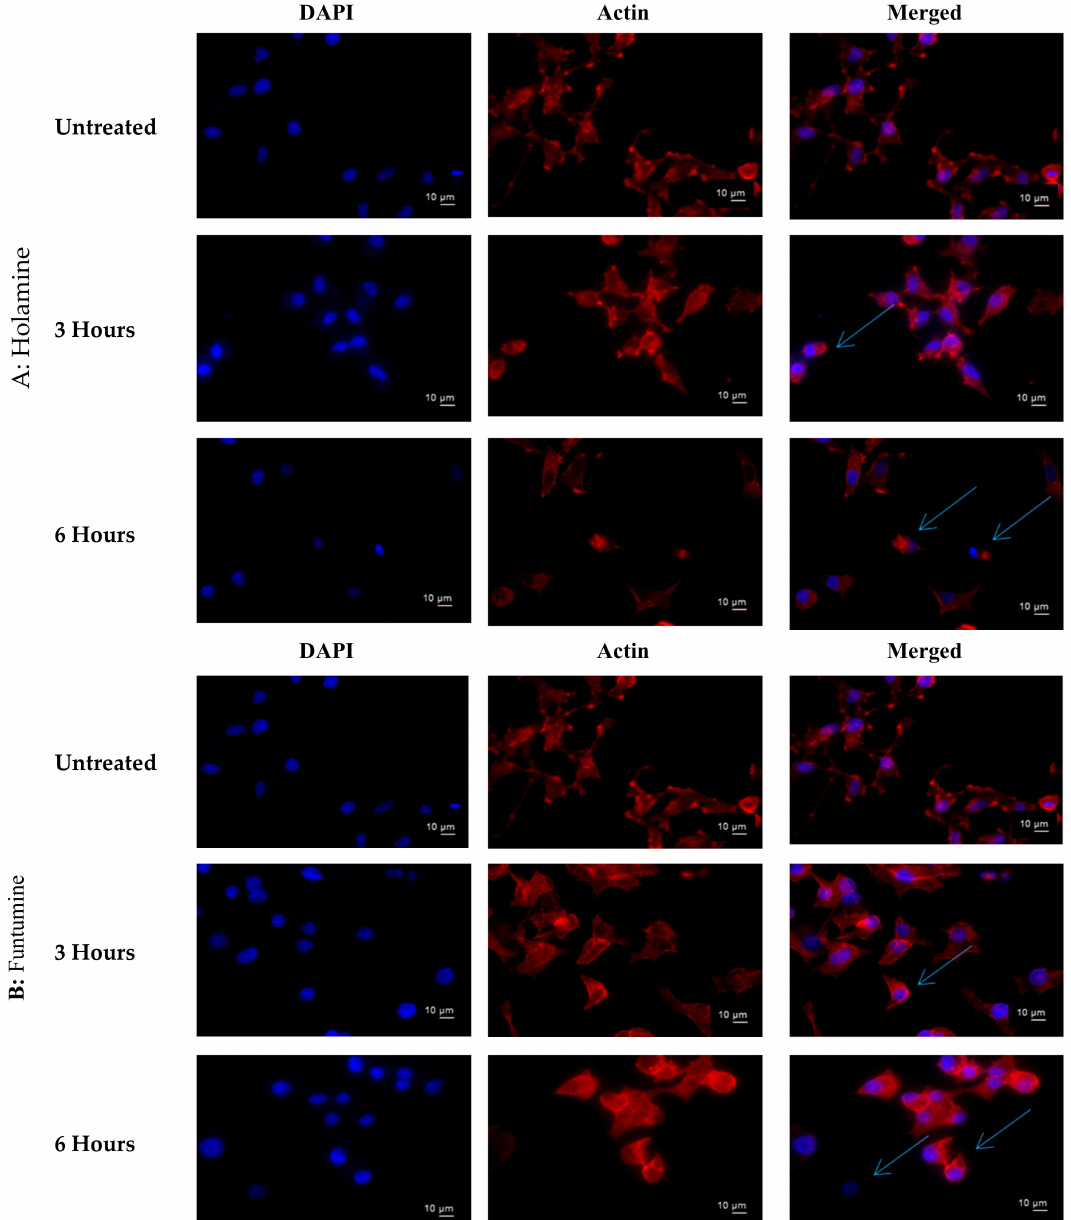
Figure 9. E ff ects of holamine ( A ) and funtumine ( B ) on the F-actin cytoskeleton of HeLa cells. Cells were treated with 15 µ g / mL of funtumine for 3 h and 6 h, fixed and stained with Tetramethylrhodamine (TRITC)-conjugated phalloidin, and viewed under a fluorescence microscope (magnification × 400) to visualize the F-actin cytoskeleton. Blue arrows indicate the sliding over of the actin filament and the exposure of the cell nuclei. Scale bars are indicated on the